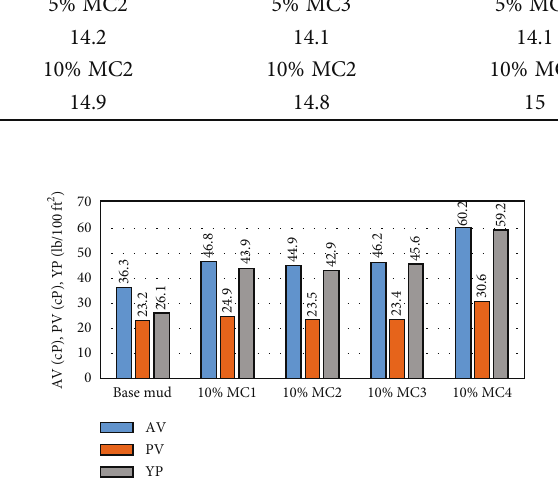
Figure 6: Rheological properties as function of adding 5% of di ff erent cuttings to the base mud.